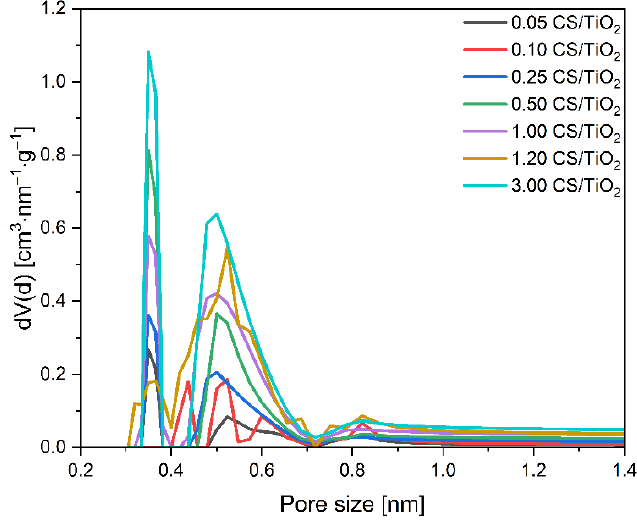
Figure 9. Pore size distributions of the obtained CS/TiO 2 composites.